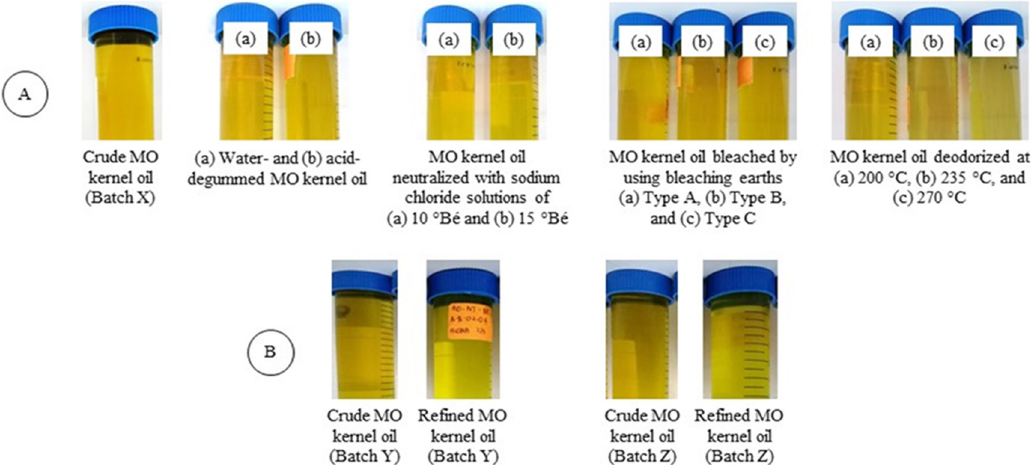
Figure 1. Images of Moringa oleifera (MO) kernel oil samples. ( A ) The oil after different refining stages. Neutralization was carried out by using sodium hydroxide solutions of different density (10 ◦ B é and 15 ◦ B é ). Bleaching was carried out by using three types of bleaching earth: Type A, Type B (acid-activated), and Type C (neutral). ( B ) The oil of different batches (Batch Y and Batch Z) after acid degumming, neutralization with 15 ◦ B é , sodium hydroxide solution, and bleaching with bleaching earth Type B.